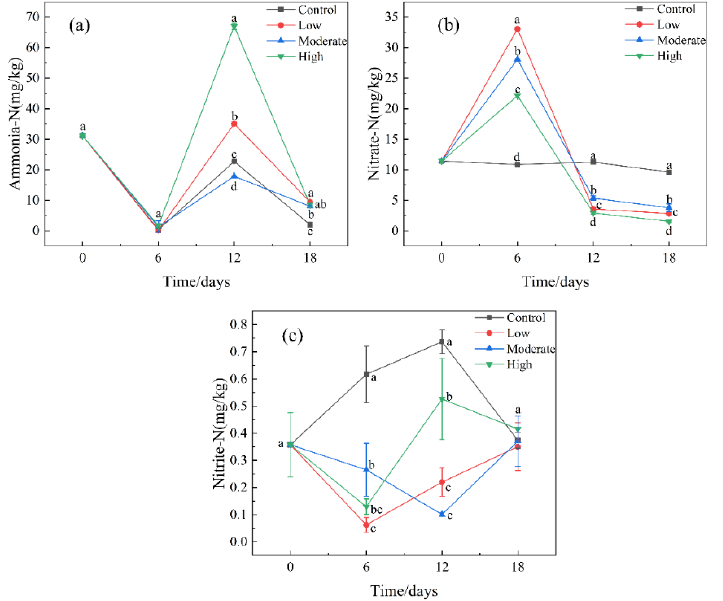
Figure 1. Changes of ( a ) Ammonia-N, ( b ) Nitrate-N, and ( c ) Nitrite-N on day 0, 6, 12, and 18 in all treatment groups. Control: the sediment with no paroxetine added ; Low: 10 μg/L paroxetine; Moderate: 100 μg/L paroxetine; High: 1000 μg/L paroxetine. The error bars represent the mean value of three groups of these samples, and the letter represents significant differences ( p < 0.05).